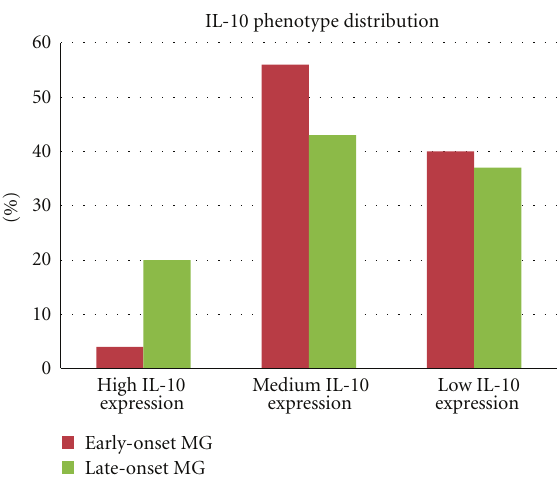
Figure 1: IL-10 phenotype distribution in the subgroups of early- and late-onset MG